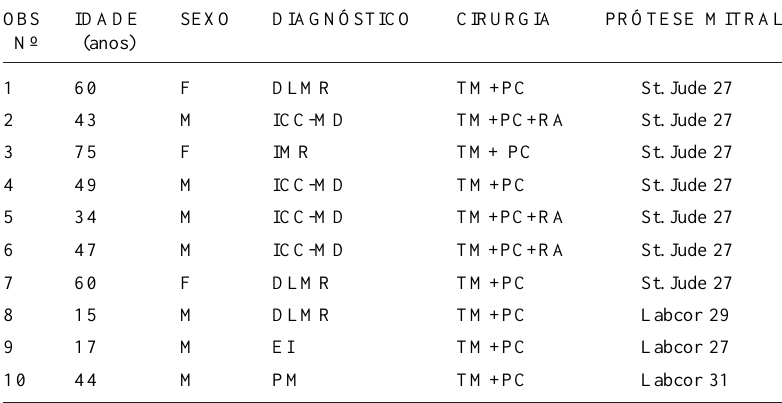
Tabela 1. Dados gerais.